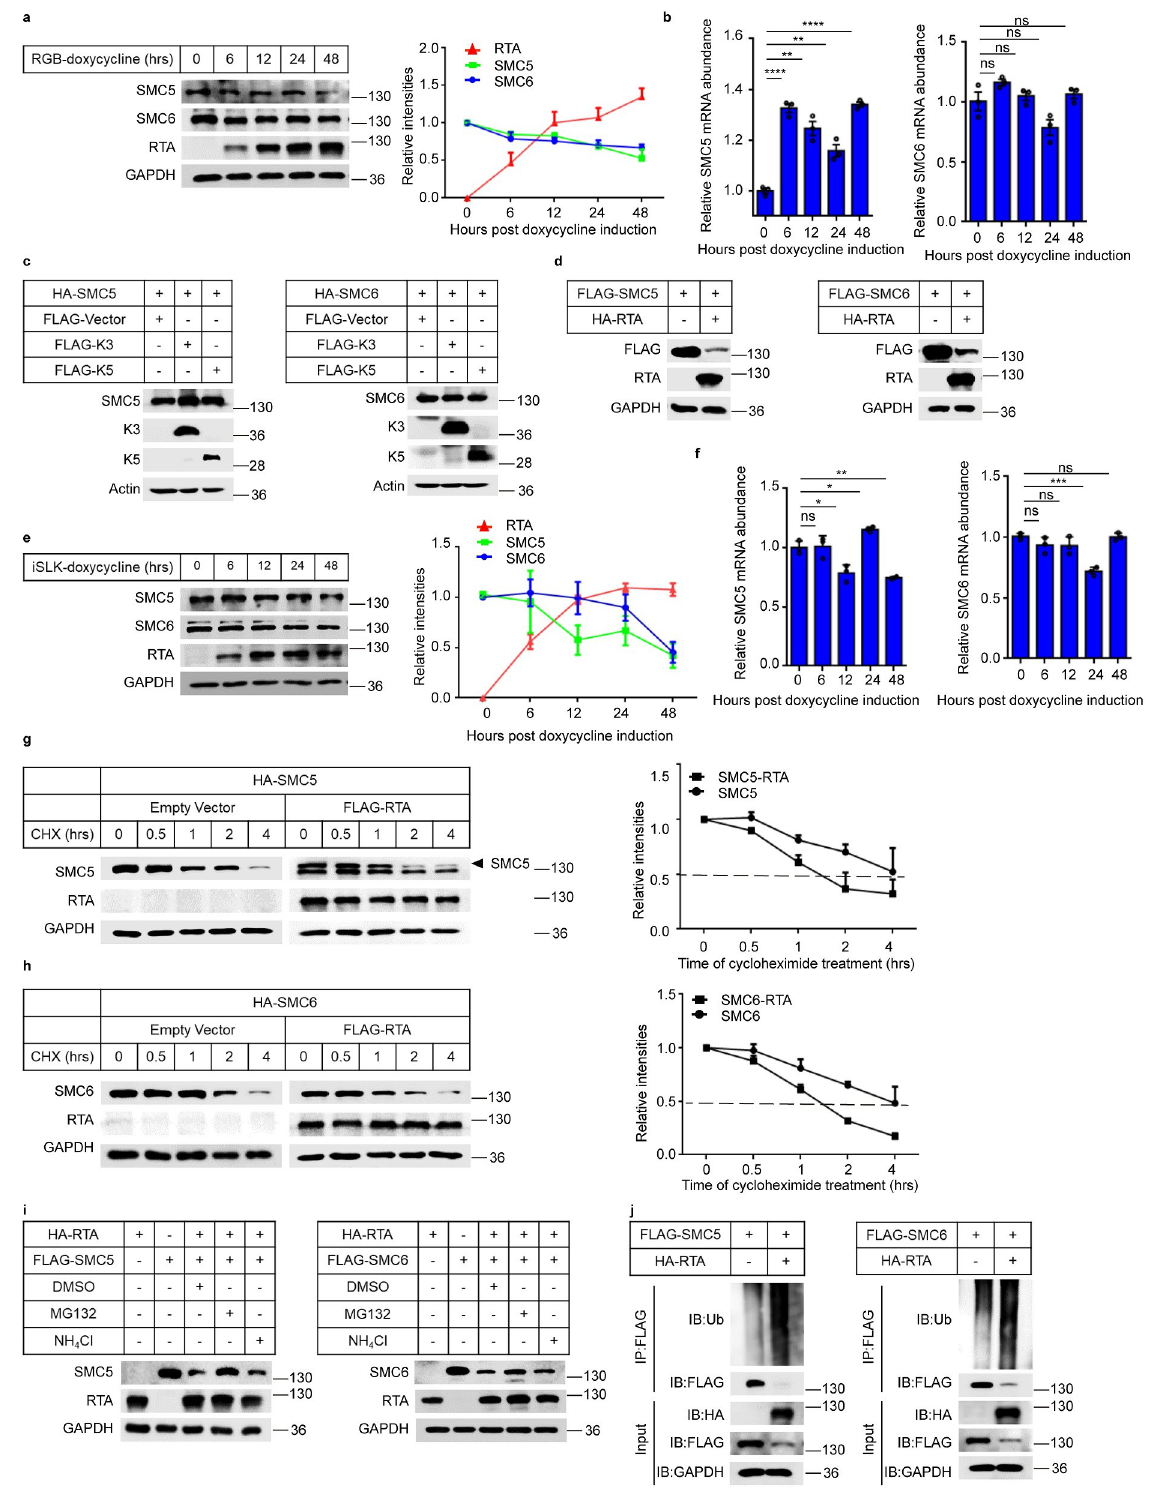
Fig 6. RTA targets the SMC5/6 complex for ubiquitination and proteasomal degradation. (a-b) The kinetics of SMC5 and SMC6 expression in iSLK.RGB cells. (a) iSLK.RGB cells were induced with Dox for indicated times. Cells were collected and SMC5, SMC6 and RTA expression were detected using western bolts. (b) The mRNA of SMC5 and SMC6 during the induction of lytic reactivation in iSLK.RGB cells were analyzed via qPCR. (c) KSHV K3 and K5 do not alter the expression of SMC5 and SMC6. HEK293T cells were transfected with